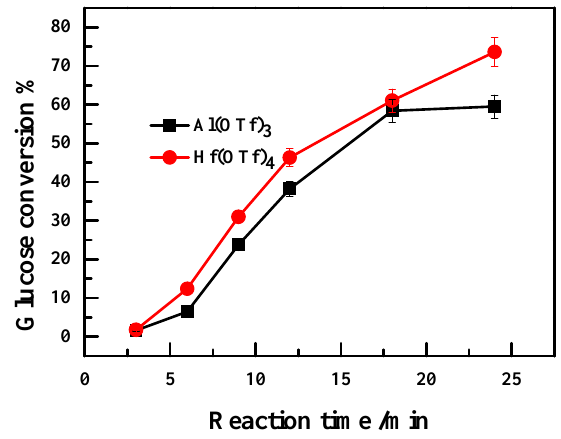
Figure 7. Effect of valence state of Lewis acid salts on the conversion of glucose. Reaction conditions: reaction temperature of 160 °C, reaction time of 25 min, 0.1 g glucose in 1.5 g 25 mM Lewis acids aqueous solution, 3 g sec-butyl phenol.